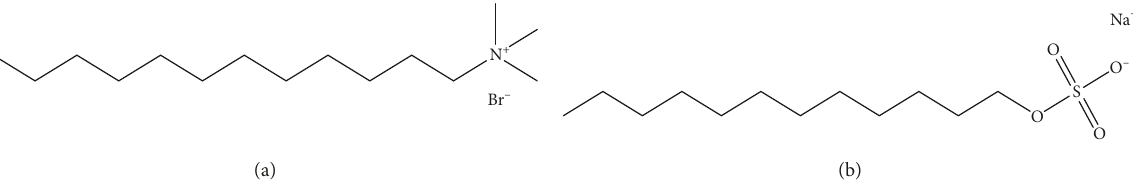
Figure 1: Molecular structure of dodecyltrimethylammonium bromide (DTAB) (a) and sodium dodecyl sulfate (SDS) (b) Table 1: Specification of chemicals used in this work.